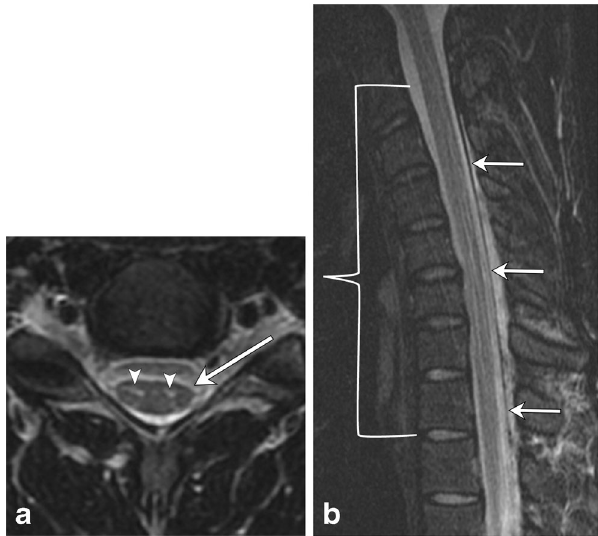
Fig.24 Hirayama disease. A 22-year-old male withupper extremity weak- ness and muscle atrophy. a There is focal T2 hyperintensity in the anterior horns (arrowheads). Subtle asymmetric focal cord atrophy at this level (C5 – C6), slightly more conspicuous on the left (arrow). b Flexion view shows anterior displacement of the dura (arrows) with narrowing of the thecal sac (bracket), extending from C3 to T2, most pronounced at C5 – C6. Note the long segment T2 hyperintensity within the anterior